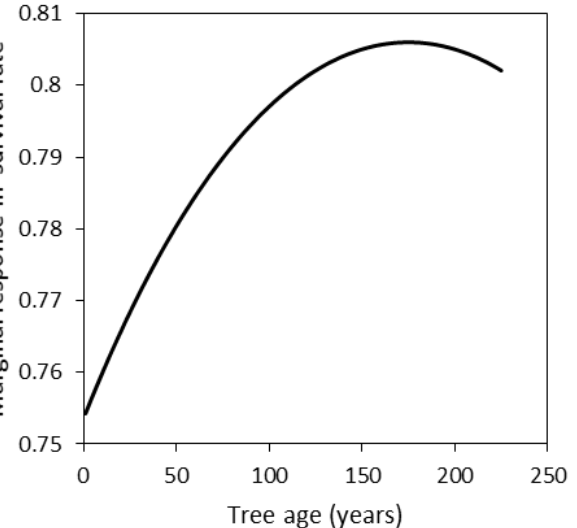
Figure 5. Marginal response for the survival rate along the range of tree age analyzed in the death trial. Table 5. Parameter Estimates and Level of Significance of the Generalized Linear Mixed Model for the Survival Rate in the Death Trial.